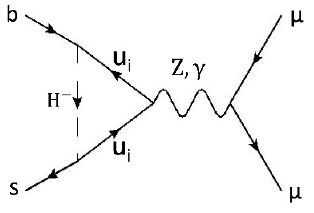
Figure 4 . Diagram that contributes to the B ! K(cid:22)(cid:22) in all